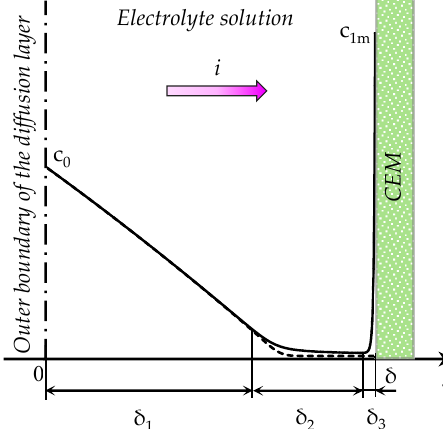
Figure 1. Schematic concentration profiles of cations ( c 1 , the solid line) and anions ( c 2 , the dashed line) in the diffusion layer adjacent to the surface of a cation-exchange membrane (CEM) [2]. The current density i is flowing across the system; the electrolyte concentration in the bulk solution, c 0 ; the cation concentration at the solution/CEM boundary, c 1m ; the minimum concentration of cations, c 1s ; δ 1 , δ 2 and δ 3 are the thicknesses of different diffusion layer regions: The electroneutral region, the extended SCR and the quasi-equilibrium electric double layer (EDL),